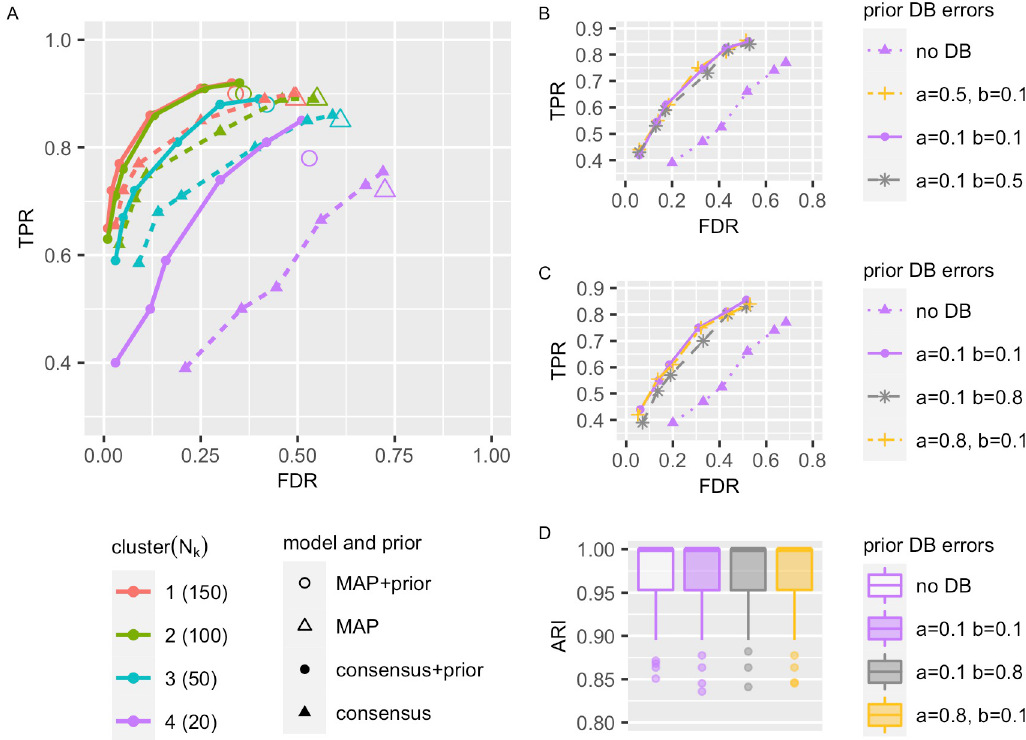
Fig 3. Structure fit. 50 datasets were generated from Bayesian network mixtures consisting of K = 4 components with number of observations N 2 f 150 ; 100 ; 50 ; 20 g corresponding to cluster 1 (red), cluster 2 (green), cluster 3 (turquoise) and cluster 4 Z k (violet). To construct the penalization matrix (prior), we first defined the edges representing interactions from databases by taking the union of all edges in the ground truth structures. Afterward, we removed 10% of these edges, modeling false-negative interactions in databases ( b = 0.1), and added 10% of false positives ( a = 0.1). The entries of the penalization matrix corresponding to the defined set were not penalized; all other edges were penalized by a factor of two. The simulated datasets were clustered using bnClustOmics with and without the penalization matrix. Resulting MAP and consensus models corresponding to posterior thresholds of p 2 {0.3, 0.5, 0.7, 0.9, 0.95, 0.99} were assessed using TPR and FDR. (B) Additional curves were added for cluster 4 visualizing results for simulated databases constructed using various levels of FDR(a) and FNR(b): a = 0.1, b = 0.1 (violet solid), a = 0.5, b = 0.1 (yellow) and a = 0.1, b = 0.5 (grey). (C) a = 0.8, b = 0.1 (yellow) and a = 0.1, b = 0.8 (grey). (D) Clustering accuracy: no database (white), a = 0.1, b = 0.1 (violet), a = 0.5, b = 0.1 (yellow), a = 0.1, b = 0.5